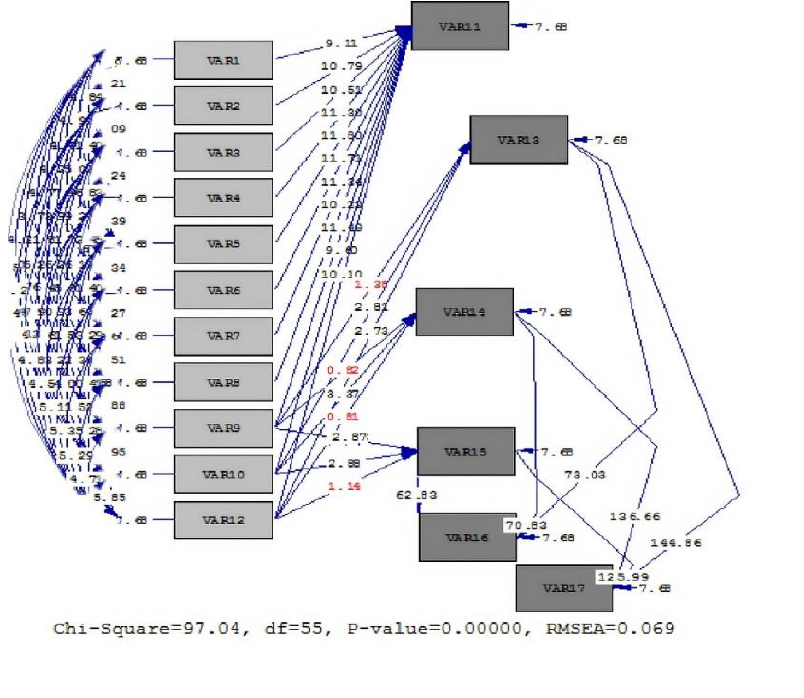
Figure 2.The Fitted Model by